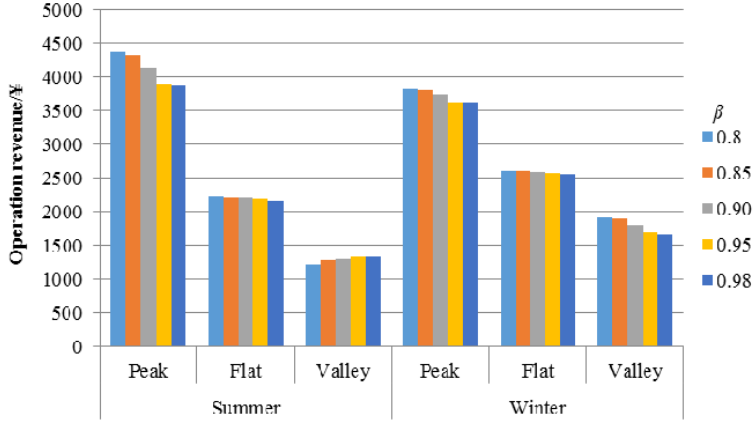
Figure 9. Revenue of VPP operation under different β in different load periods.